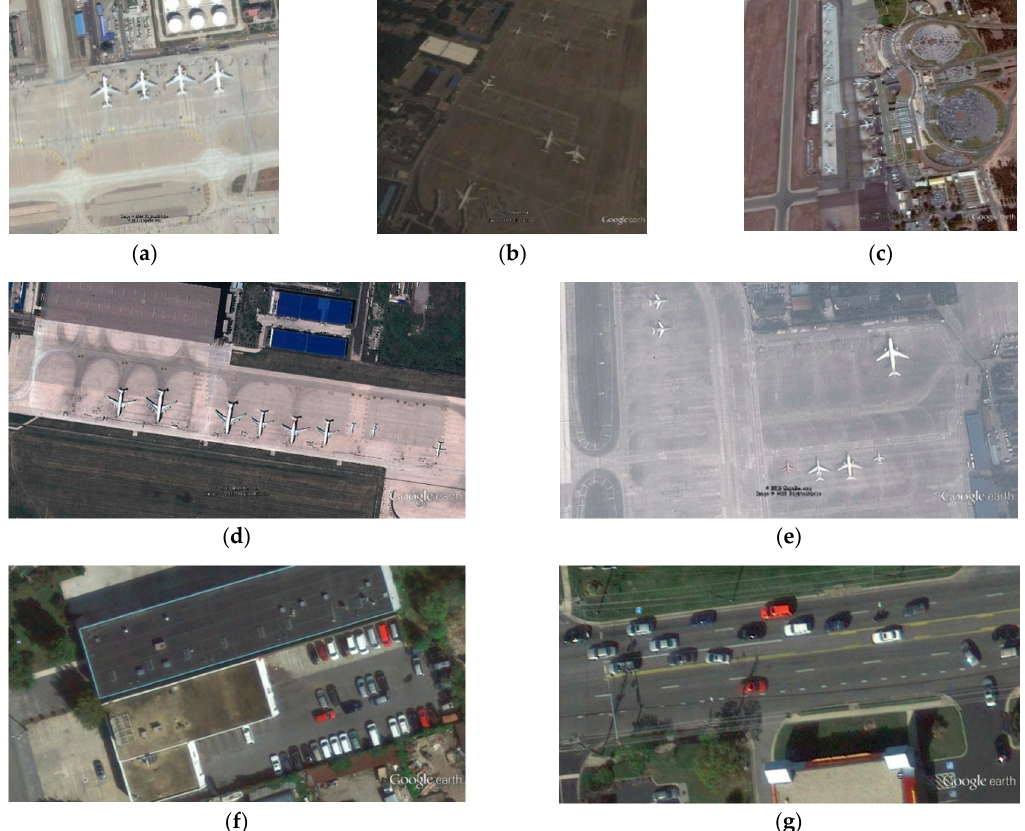
Figure 9. The samples of the dataset. (a) Aircraft and oiltank targets (b) Small aircraft targets under weak light condition (c) Small aircraft targets under complex background. (d) Small aircraft targets. (e) Small aircraft targets under bad weather condition. (f) Densely contributed car targets (g) Car